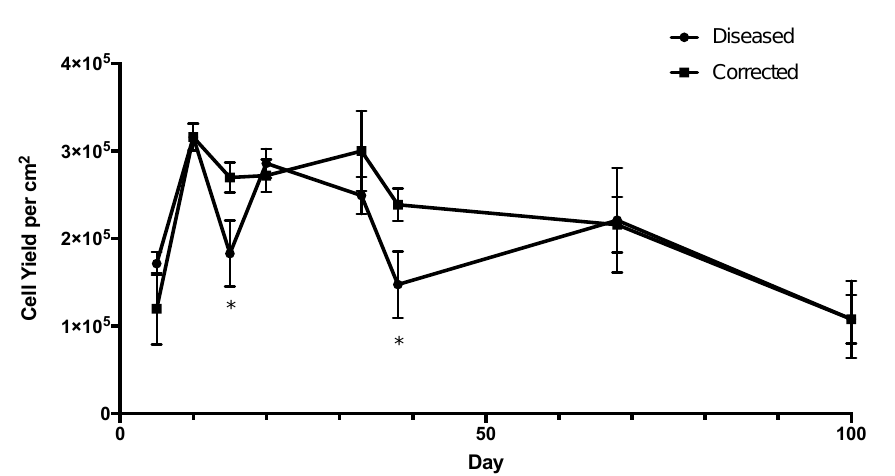
Figure 6. Atrophy of RPE cells upon extended passage. RPE cells were passaged enzymatically at each time point shown at a seeding density of 1 × 10 5 cells per cm 2 and allowed growing for 5 to 30 days per passage. Both diseased and corrected RPE cells were able to proliferate until day 100. N = 12, * p <